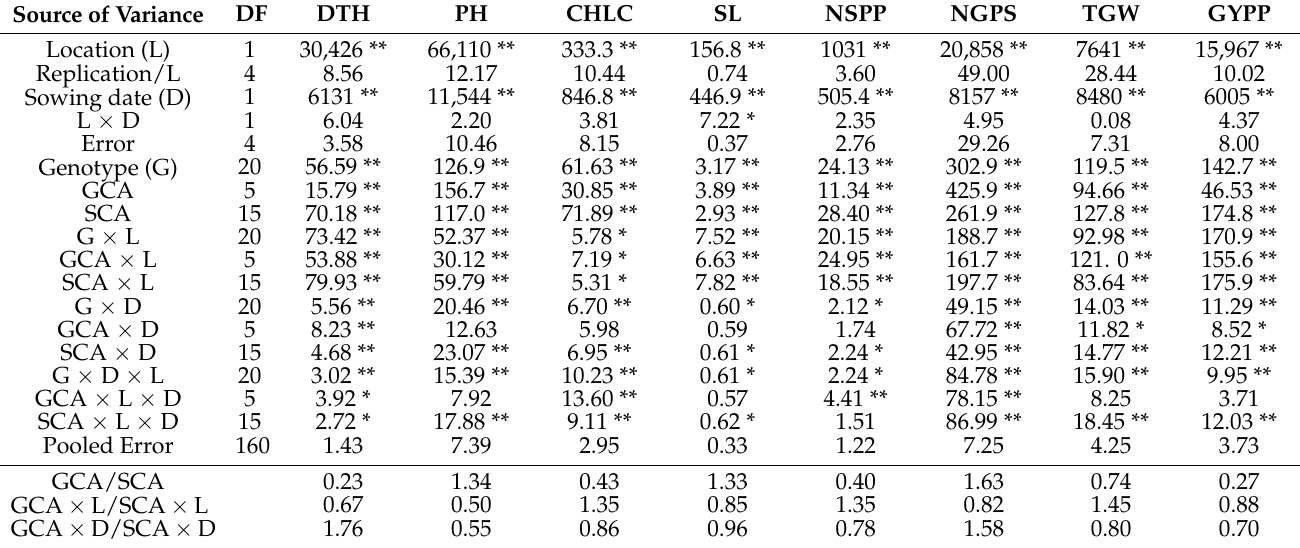
Table 1. Combined analysis of variance for all studied traits across tested